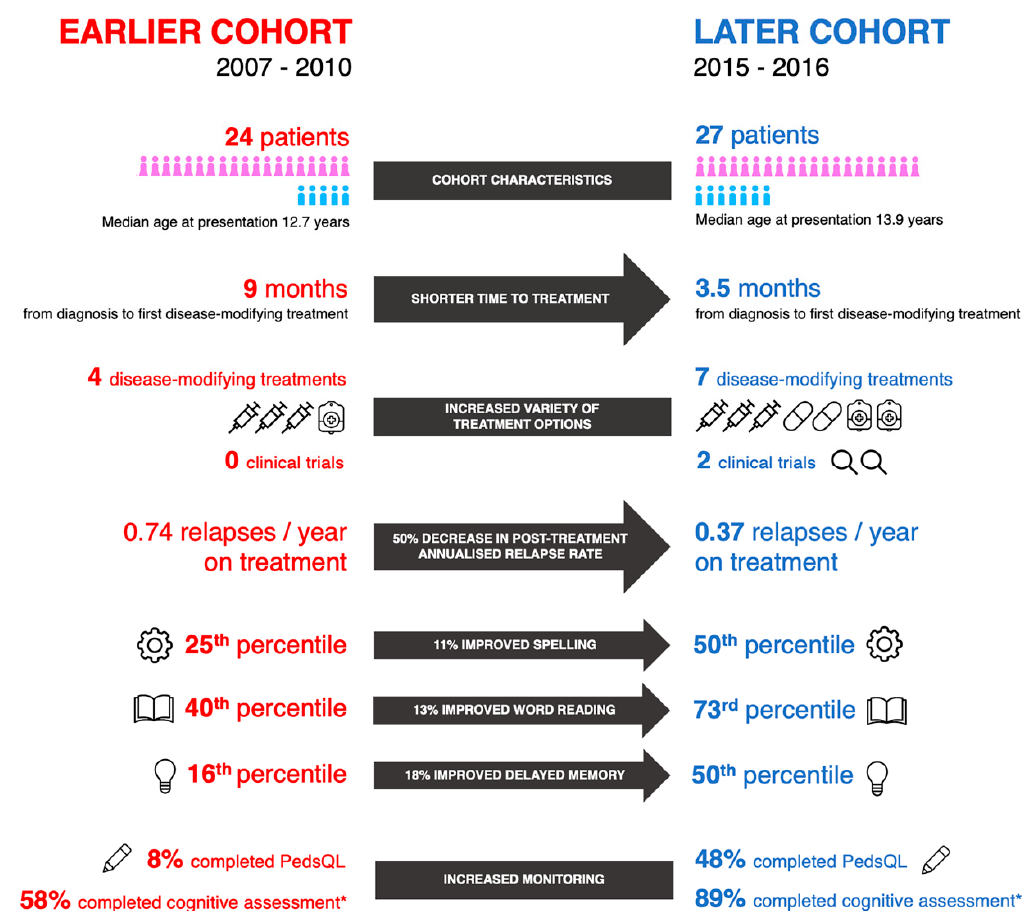
Figure 3. Key improvements over the study period when comparing the two cohorts. Arrows show direct compared outcomes, blocks demonstrate unquantified differences.